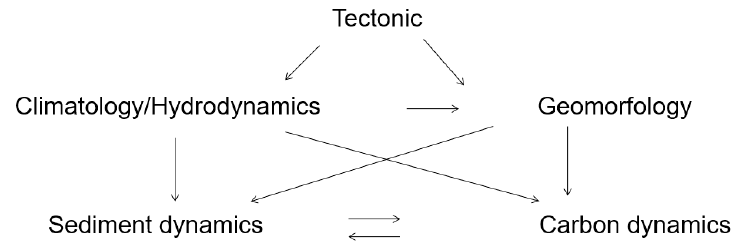
Figure 4. Schematic representation of the interrelation of physical drivers and oceanographic pro- cesses represented in the models.